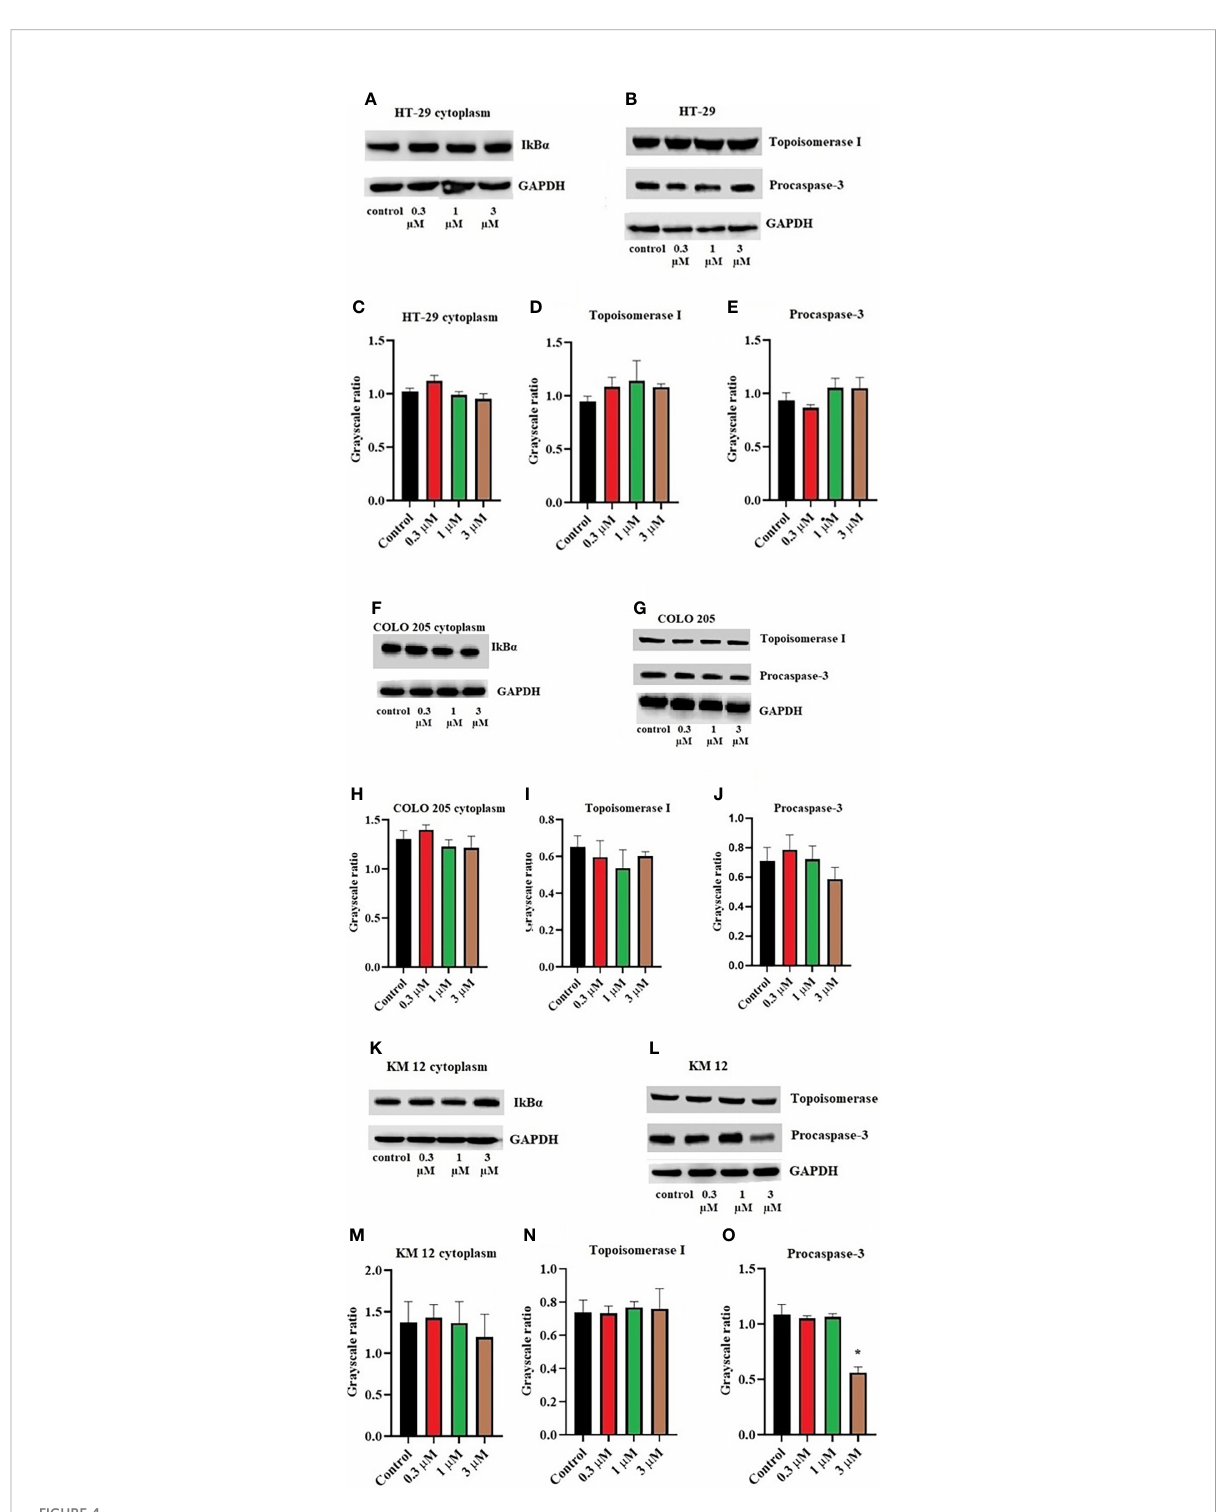
FIGURE 4 Effect of ITH-6 on the expression of cytoplasmic expression of IkB a , Topoisomerase I, and Procaspase-3 on (A, B) HT-29, (F, G) COLO 205, and (K, L) KM 12 cells. The effect of ITH-6 on the expression of Topoisomerase I, Procaspase-3, and IkB a (cytoplasmic) was tested after the cells were treated with 0.3, 1, and 3 m M of ITH-6 for 72 hours. Relative quanti fi cation of the effect of ITH-6 on cytoplasmic IkB a on (C) HT-29, (H) COLO 205, and (M) KM 12 cells, Topoisomerase I on (D) HT-29, (I) COLO 205, and (N) KM 12 cells, and Procaspase-3 on (E) HT-29, (J) COLO 205, and (O) KM 12 cells. The expression levels of the target proteins were normalized to GAPDH. Equal amounts of total cell lysates were used for each sample, and a Western blot analysis was performed. The fi gures are representative of three independent experiments. * p <.05 compared with the control